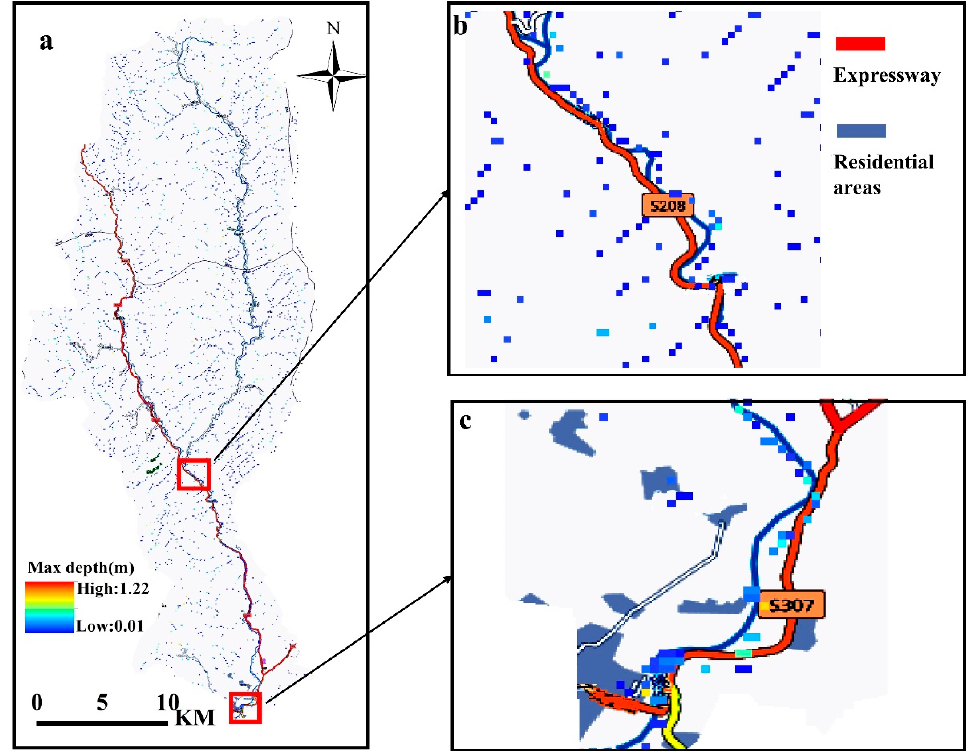
Figure 10. Maps of the maximum water depth. Table 6. Flood inundation in different grades.